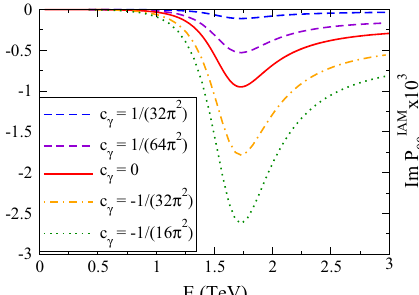
Fig. 3 With a = 0 . 81, b = a 2 , a 5 (μ = 0 . 75 TeV ) = 0 . 0023 and other NLO parameters at that scale set to zero, the IAM accommodates a narrow resonance in the scalar channel. We show the imaginary part of the elastic amplitude and the imaginary part of the scalar photon amplitudes (multiplied by 10 3 as in Fig. 2)